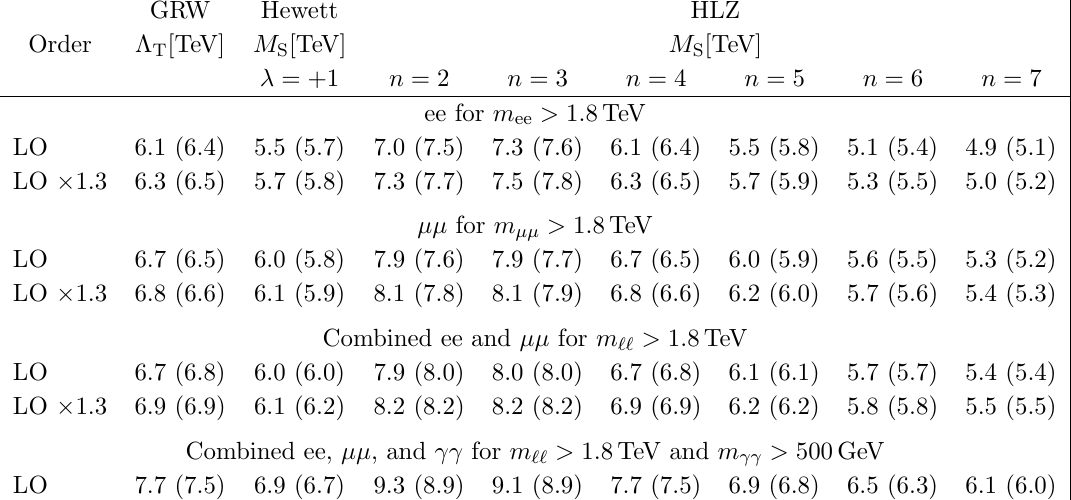
Table 2 . Exclusion limits at 95% CL for the electron and muon channels, their combination, and the combination with the diphoton [10] analysis, in multiple parameter conventions of the ADD model. Signal model cross sections are calculated up to leading order and, where indicated by the appropriate label, a correction factor of 1.3 is applied. For each of the model parameters, the (cid:12)rst value is the observed limit followed by the expected limit in